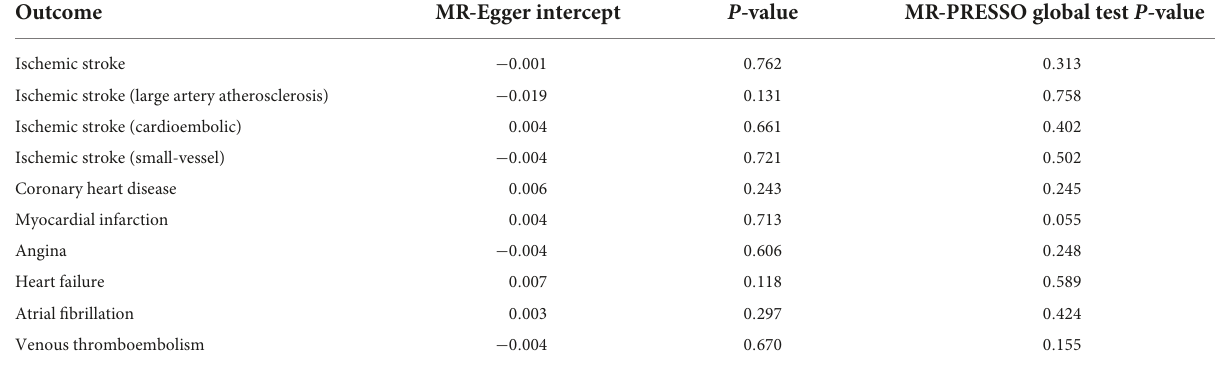
TABLE 3 Evaluation for